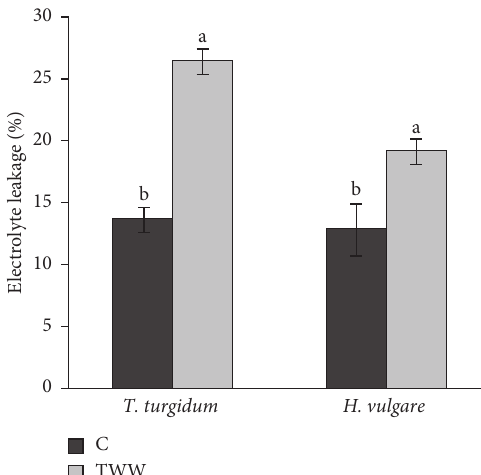
Figure 4: Electrolyte leakage and H 2 O 2 of T. turgidum and H. vulgare leaves cultured in control soils and wastewater irrigated soils. Means of four replicates. Bars marked with the same letter are not significantly different at p < 0 . 05.